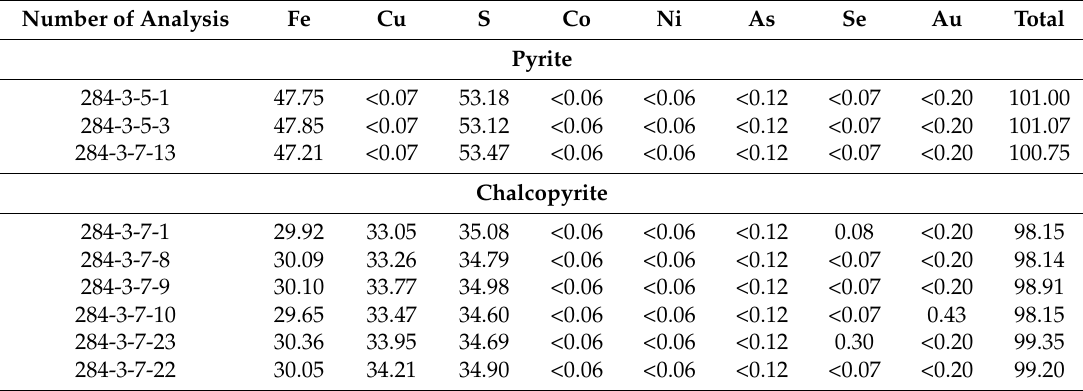
Table 4. Composition of selected sulfides according to microprobe analysis, wt